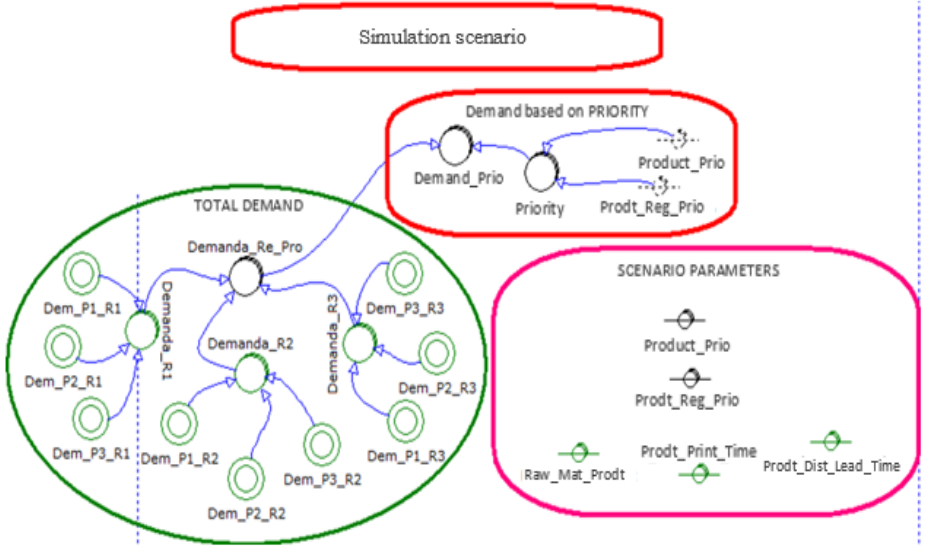
Figure 10. Total demand—scenario 2. Source: own elaboration by Evolution software. Figure 11. Total demand — scenario 2. Source: own elaboration by Evolution software. Two key aspects are highlighted in this modeling. The first is that each